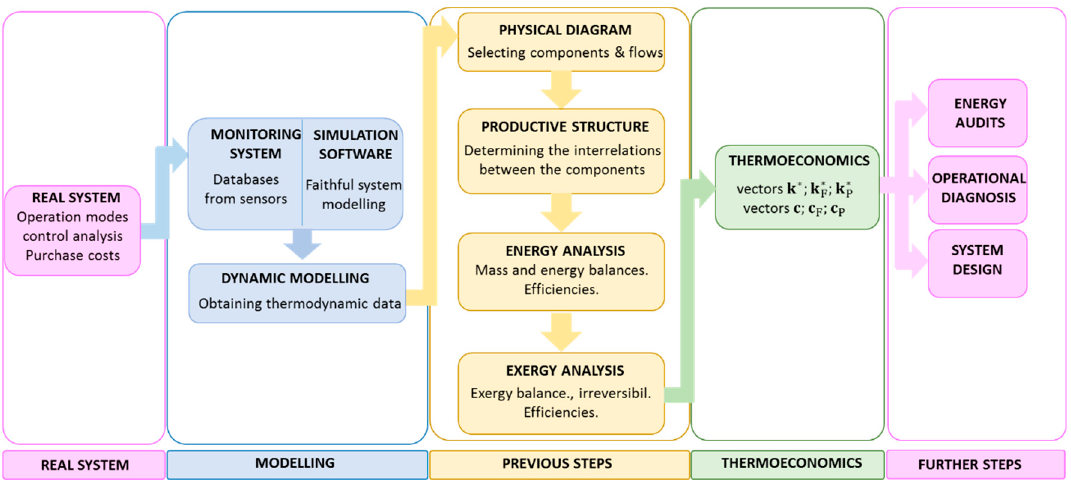
Figure 2. The steps for applying thermoeconomics to a building thermal facility.